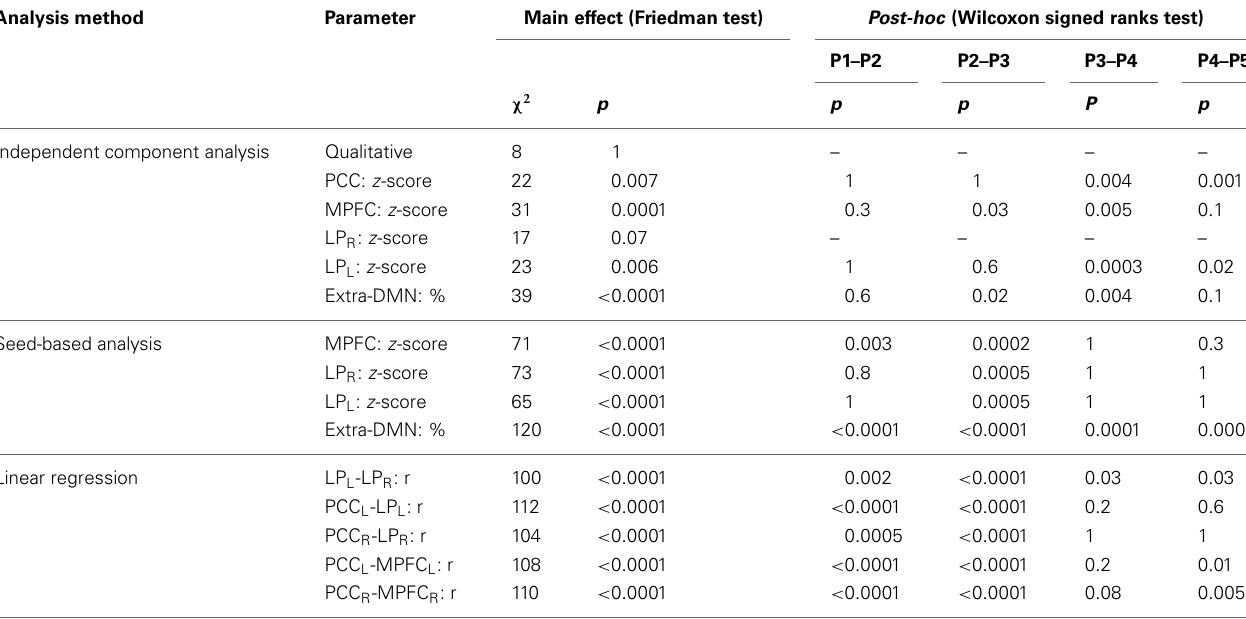
Table 2 | Statistical evaluation of the effect of the preprocessing procedures for healthy controls.